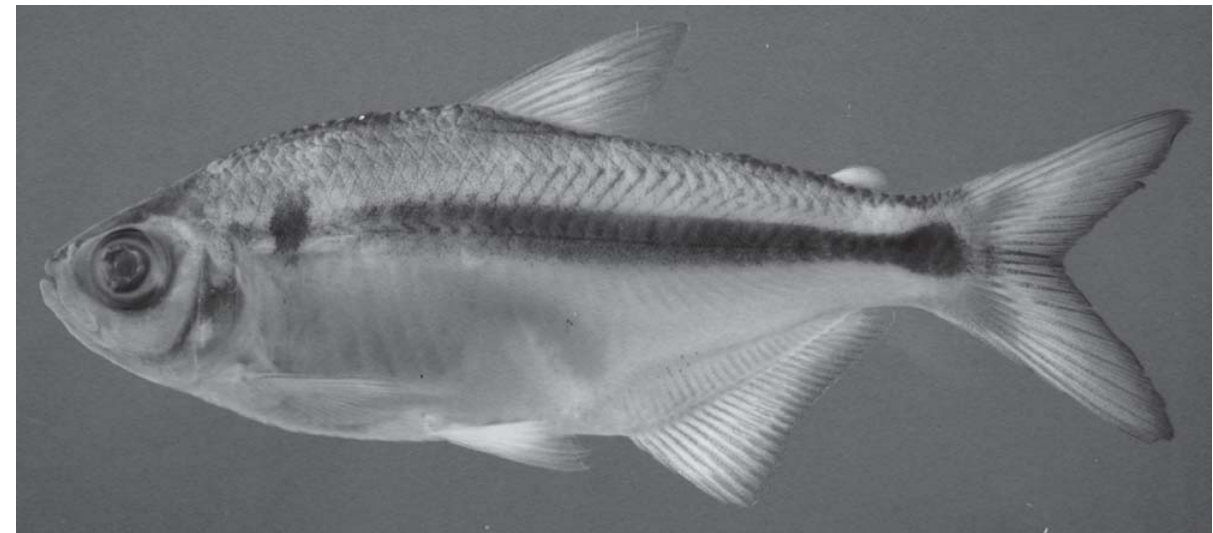
Fig. 6. Astyanax sp. aff. fasciatus , MNRJ 25570, 87.8 mm SL, male, lago Guaíba, Rio Grande do Sul,